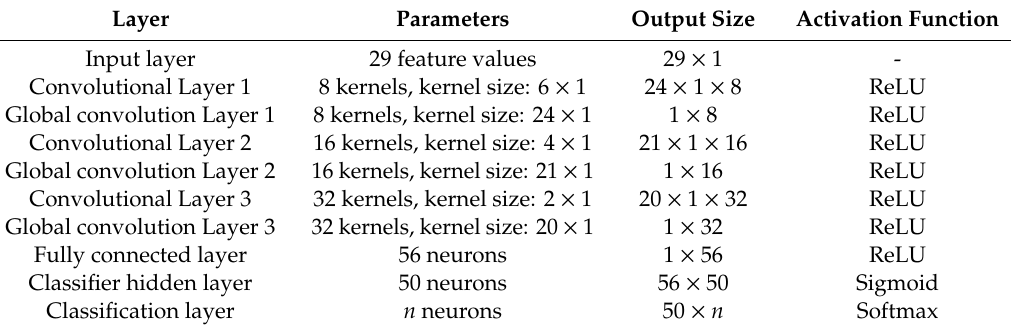
Table 4. Specific setting parameters of the simplified shallow information fusion-convolutional neural network (SSIF-CNN). Layer